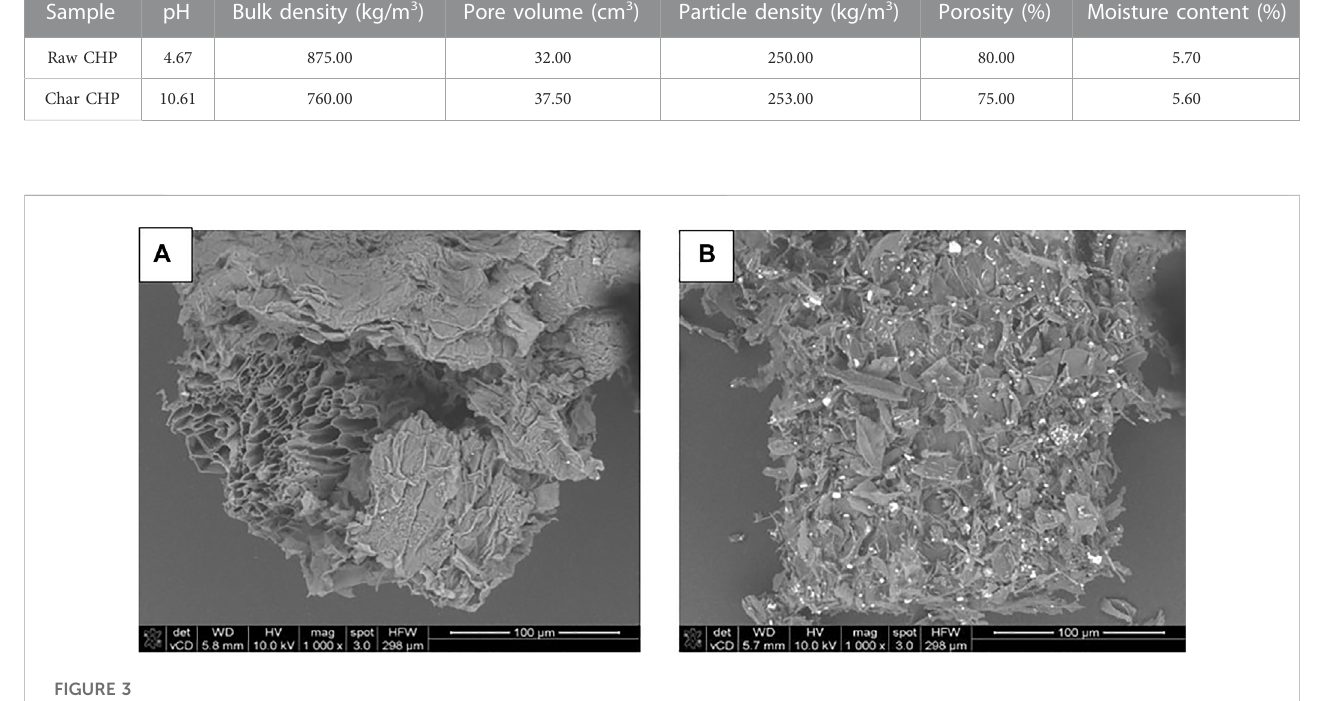
FIGURE 3 (A) SEM image of RCHP (B) SEM image of